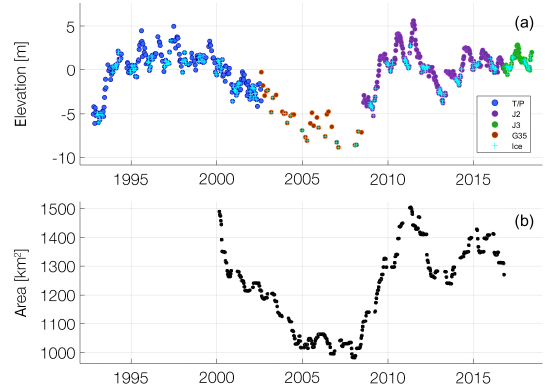
Figure 5. Time series of (a) water elevation variation by mission (1144 records) and (b) MODIS-estimated surface area (578 records) for Lake Sakakawea. Presence of surface ice is indicated by a light blue cross.